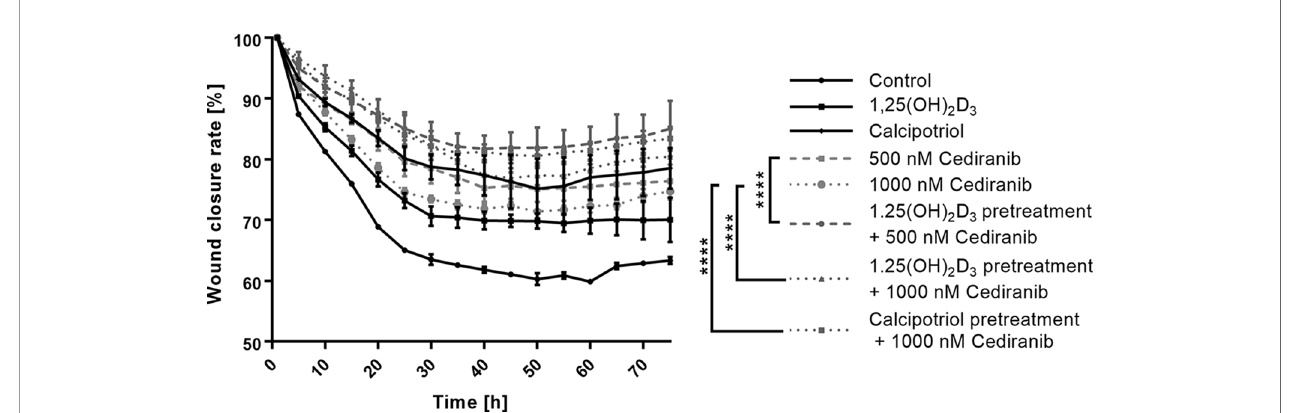
FIGURE 3 | The effect of 24-h preincubation with vitamin D analogs at 100 nM concentration on the rate of a wound closure in A375 human malignant melanoma cells treated for 72 h with cediranib either at 500 or at 1,000 nM concentration. The cell-free area of each wound was measured at the different time points, every 30 min for 72 h as a live imaging in Olympus cell Vivo IX 83, and results were calculated in % as a wound closure rate with the Olympus cell Vivo IX 83 software. Statistical values were calculated with one-way analysis of variance and Tukey ’ s post-hoc test and presented as **** p <